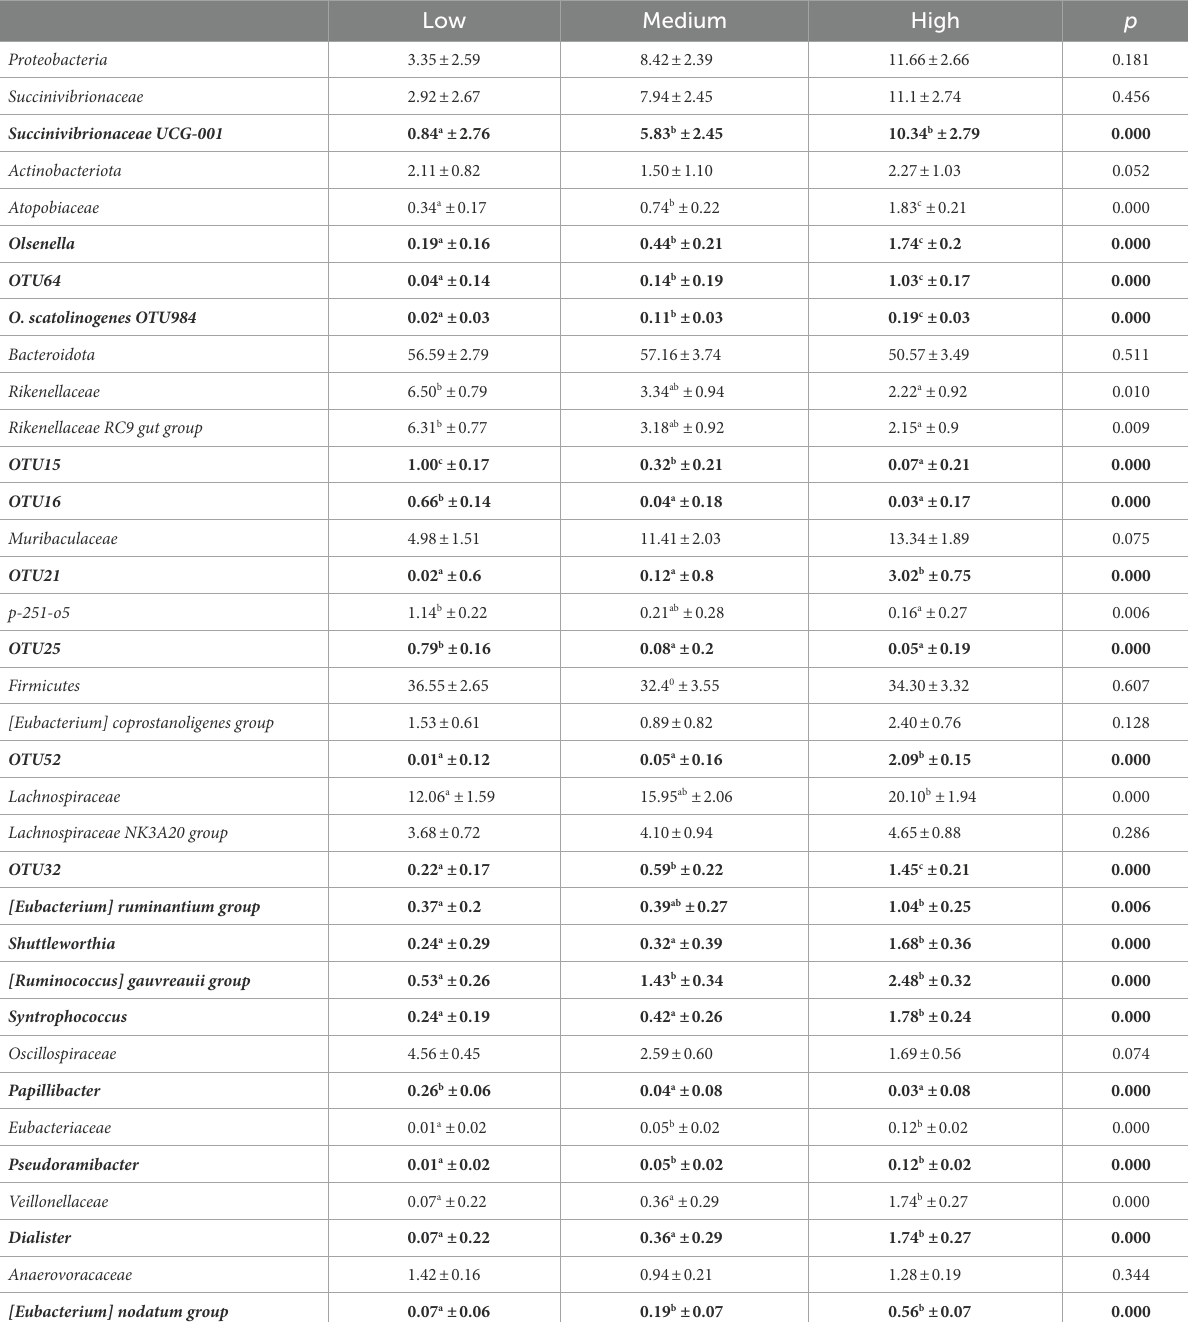
TABLE 2 Relative abundance (least squared mean percentages ± SE of GBM transformed values) of genera and OTUs selected by sPLS-DA (bold) and their affiliation groups for the three classes of trans -10/ trans -11 ratio. Low Medium